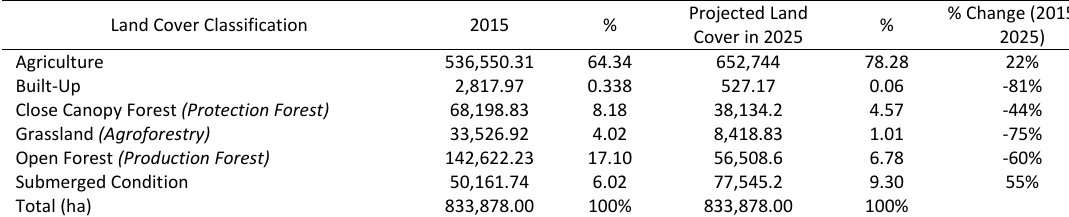
Table 3: Land cover classification of the projected land cover in 2025 in ha Land Cover Classification